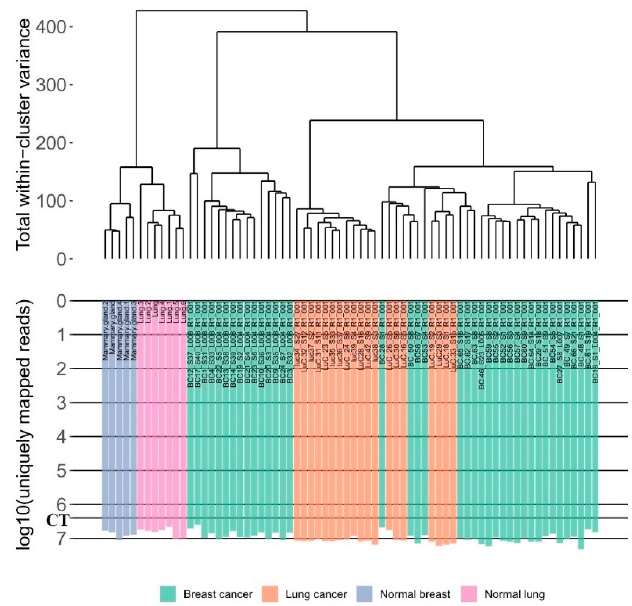
Figure 2. The hierarchical clustering dendrogram of experimental RNA sequencing profiles of breast and lung cancer and corresponding normal tissues from the ANTE database. Gene expression data were used to calculate Euclidean distances between the samples. The color markers indicate tissue types. The lower scale indicates the number of uniquely mapped reads. ‘CT’ denotes the coverage threshold of 2.5 million uniquely mapped reads.